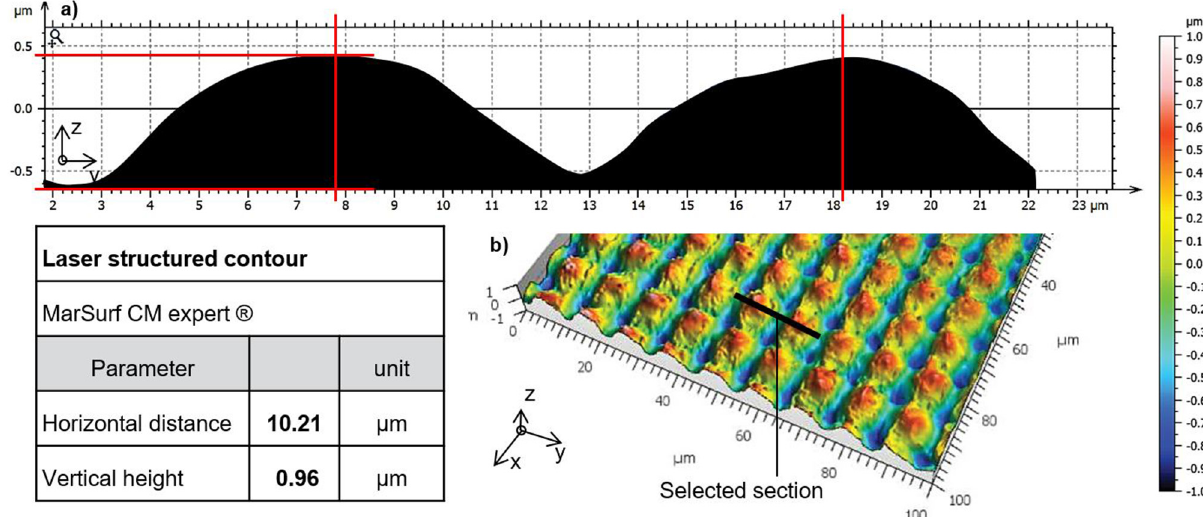
Fig. 4. Scanning confocal microscopic results. (a) Cross section and (b) more detailed 3D topography of xDLIP structured surface contour.